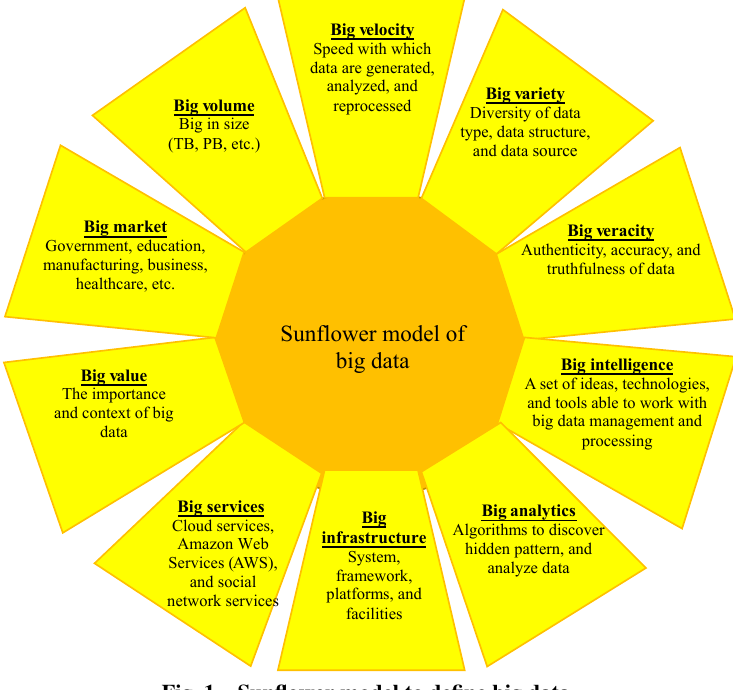
Fig. 1 Sunflower model to define big